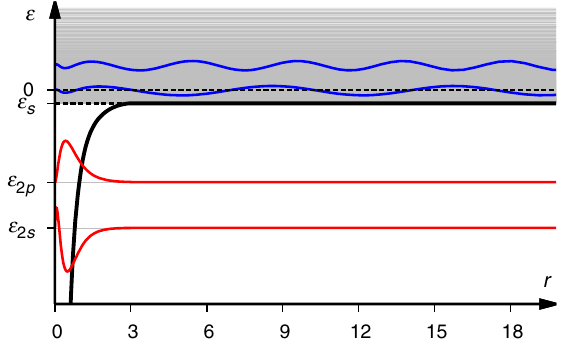
FIG. 2. Plots of bound- and continuum-state energies of Al at zero temperature, obtained by diagonalization of the discretized Hamiltonian matrix. Some bound- and continuum-state wave functions are also plotted. The maximum radius is r 100 a.u. used in the